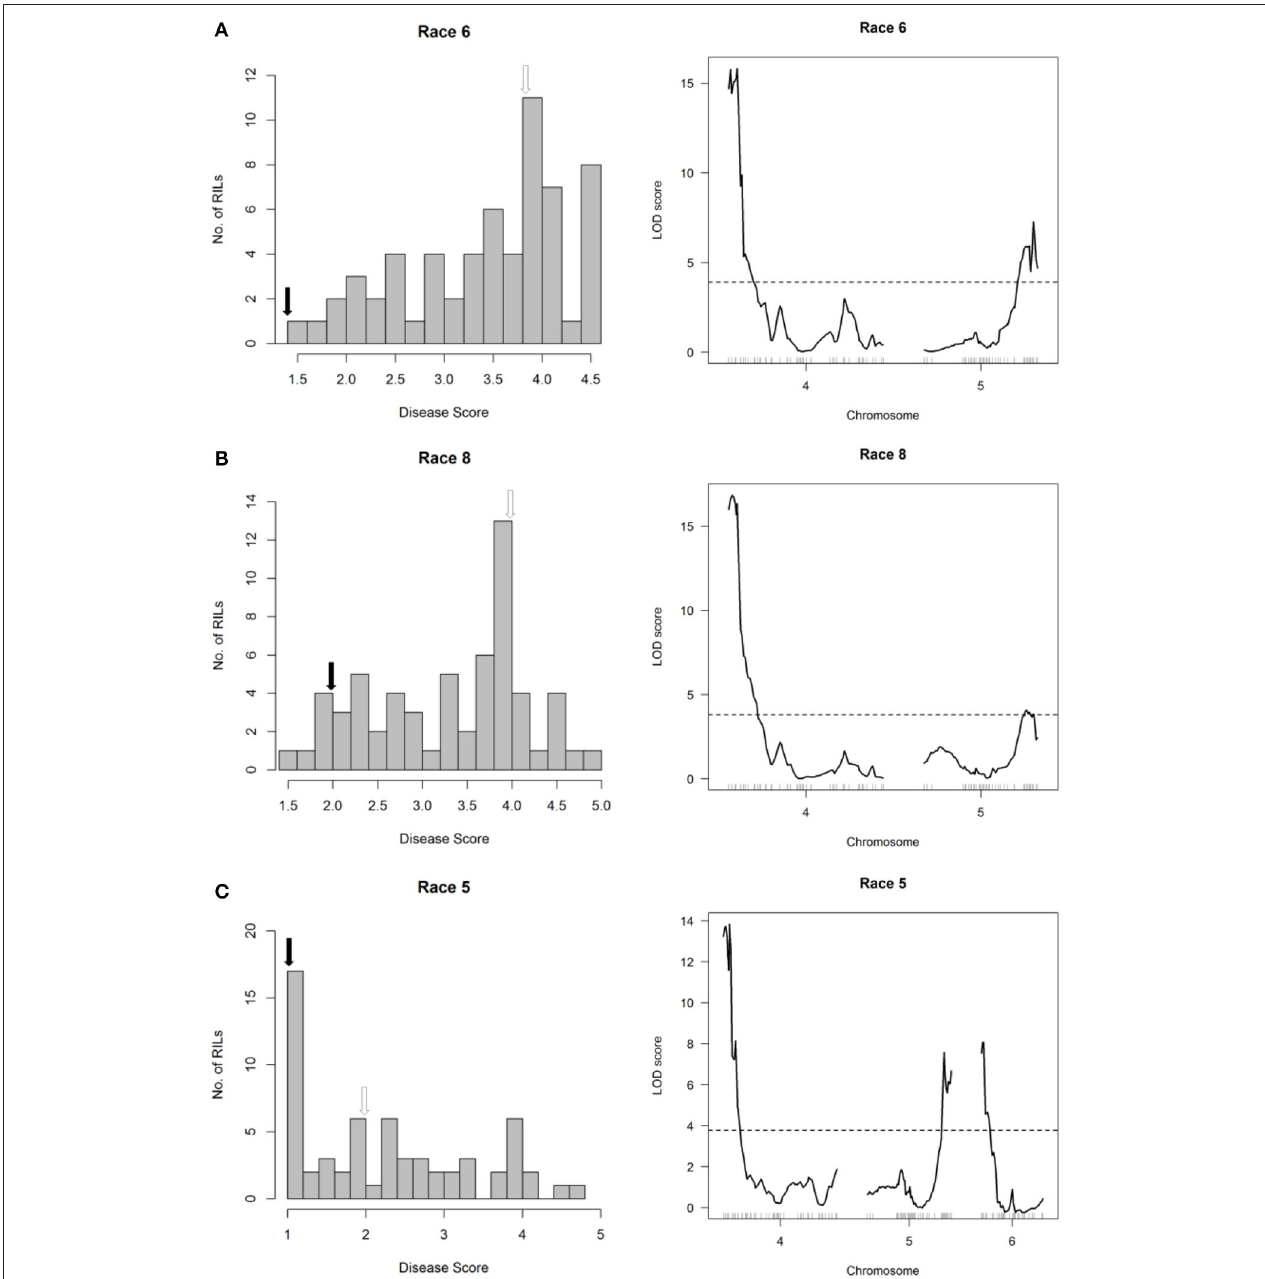
FIGURE 5 | Resistance mapping in the Phaseolus vulgaris Canadian Wonder × PI 150414 (CP) recombinant inbred population following separate inoculations with (A) Race 6, (B) Race 8, or (C) Race 5 of Pseudomonas syringae pv. phaseolicola detects QTL on Pv04, Pv05, and Pv06. (Left graphs) Distribution of interaction phenotypes exhibited by CP inbreds in glasshouse experiments. The phenotype scale ranges from highly resistant (score 1.0) to fully susceptible (score 5.0). White arrows denote the mean disease score for Canadian Wonder and black arrows denote the mean disease score for PI 150414. (Right graphs) LOD profiles obtained by one-dimensional and two-dimensional genome scans. QTL models were fitted and refined using the multiple imputation method. Dashed lines denote significance at the 0.05 probability level.